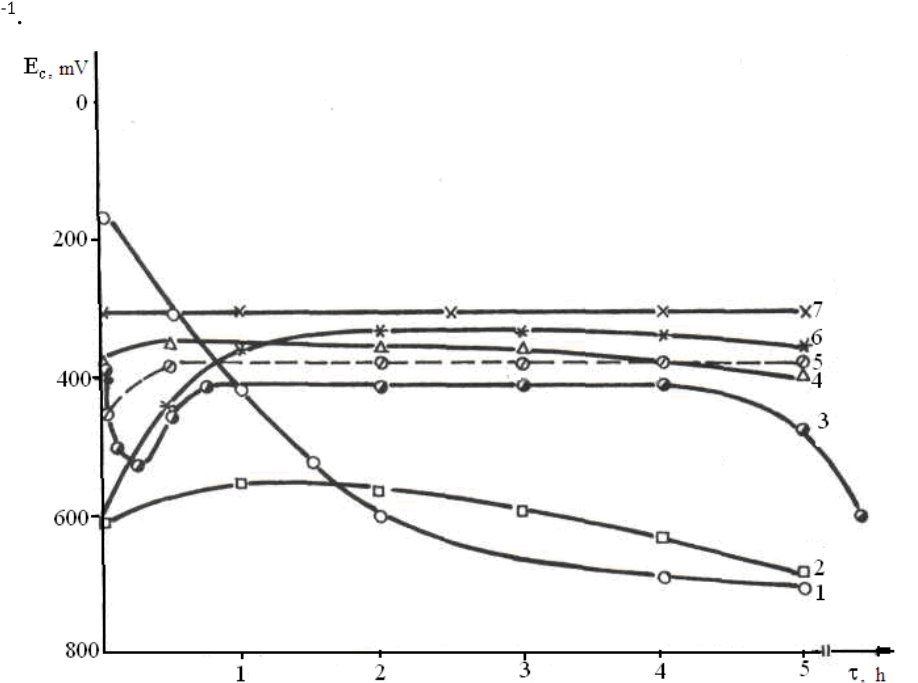
Figure 2. Changing in time the corrosion potential of palladium deposited samples (without annealing and after annealing) in water solutions of 10; 20; 30 and 40% H 80 °C and at 100 °C: 1 – 10% H annealing, 3 – 10% H